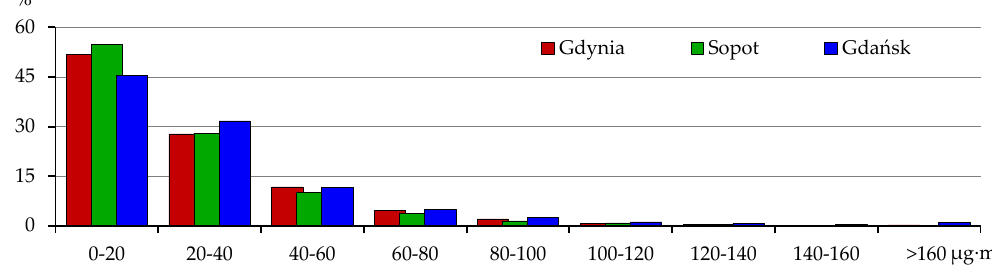
Figure 4. The frequency distribution of hourly concentrations of PM 10 in the Agglomeration of Tricity during the winter seasons (D, J, F) in 2002/2003–2016/2017.